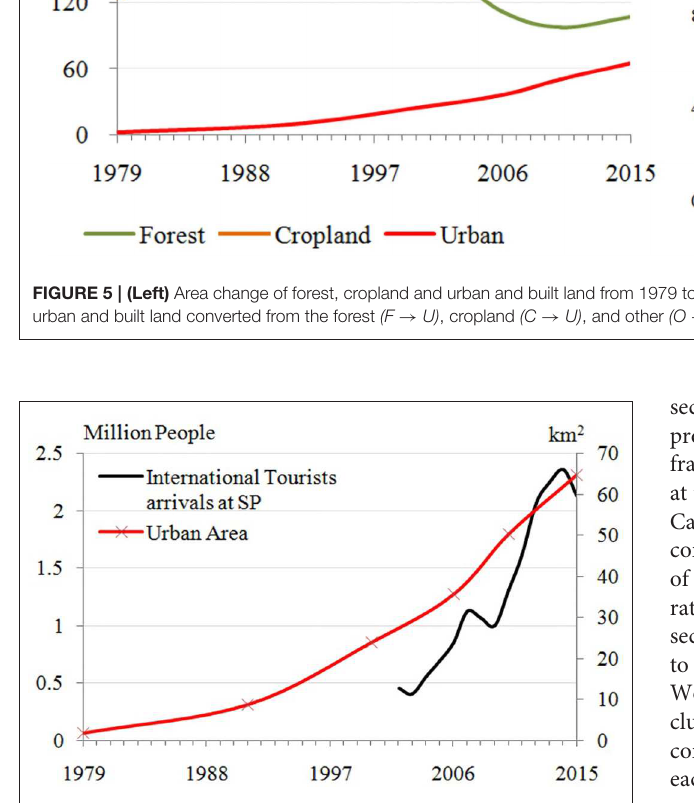
FIGURE 6 | Urban and built land area and tourists